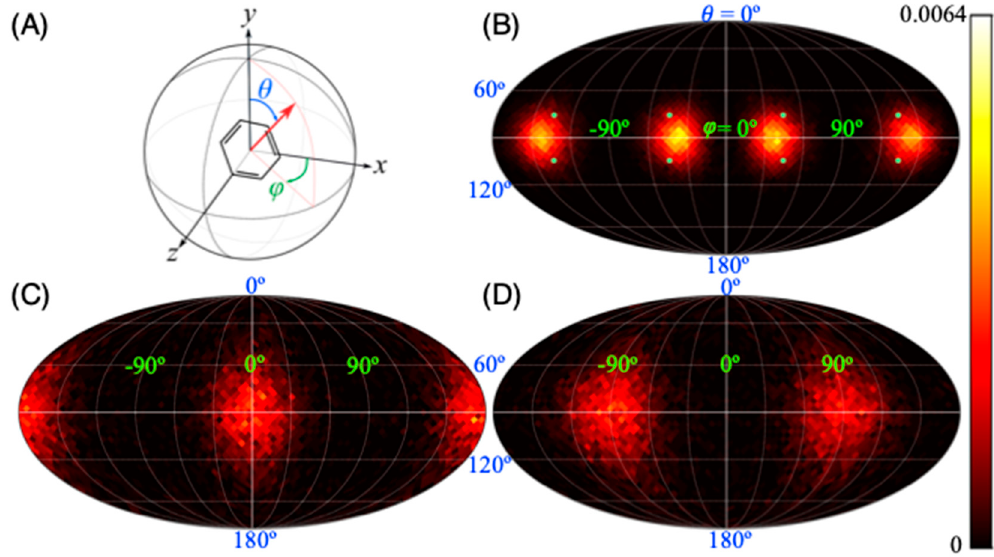
Figure 5. Probability density of the normal benzene vector ( A ) whose orientation is defined by angles θ and ϕ . The normalized distributions for ( B ) phase I (100–120 ps), ( C ) M1, and ( D ) M2 layers in the metastable phase (490–510 ps) are depicted using HEALPix, such that each pixel represents an equal area on the spherical surface. The experimentally obtained orientation for phase I [11] is shown in green circles.